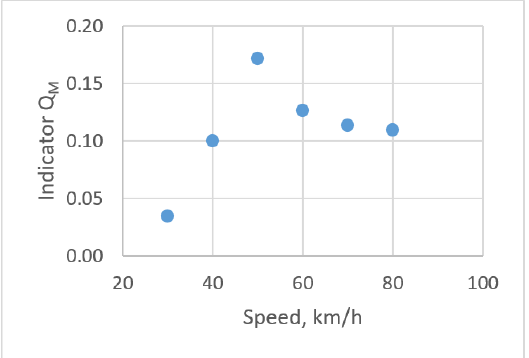
Figure 18. Values of Q M considering to the mean vertical forces of unloaded goods wagon.